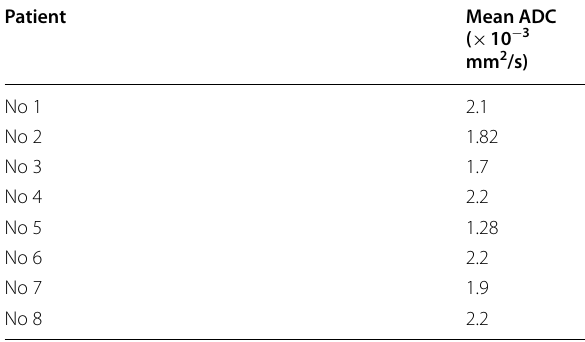
Table 4 Mean ADC value in the 8 patients with concurrent